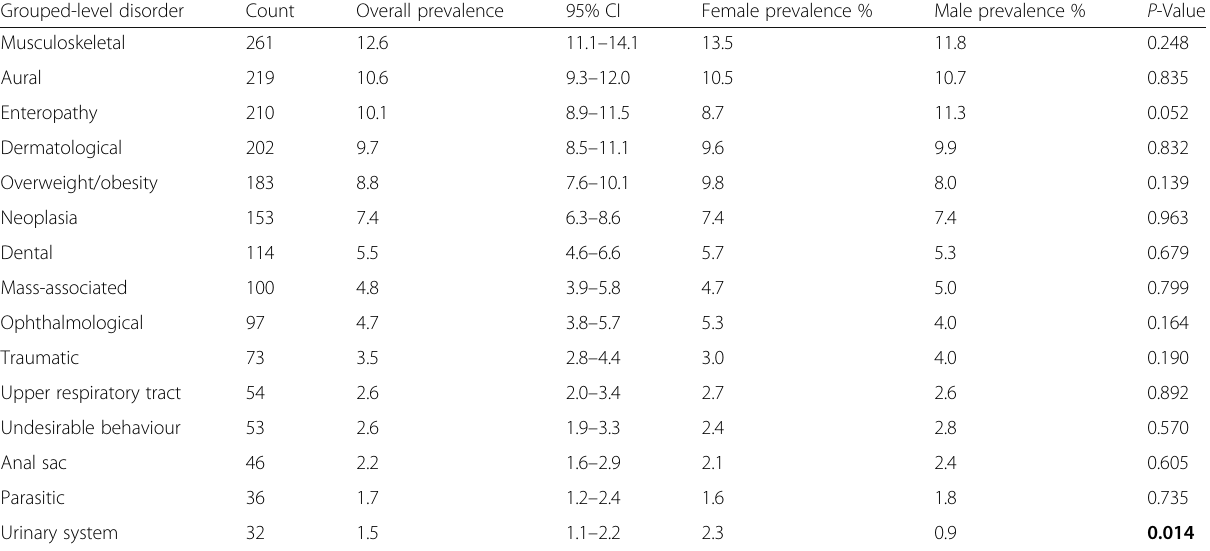
Table 4 Prevalence of the most common grouped-level disorders recorded in Labrador retrievers ( n = 2074) attending UK primary- care veterinary practices participating in the VetCompass ™ Programme from January 1st 2013 to December 31st 2013 Grouped-level